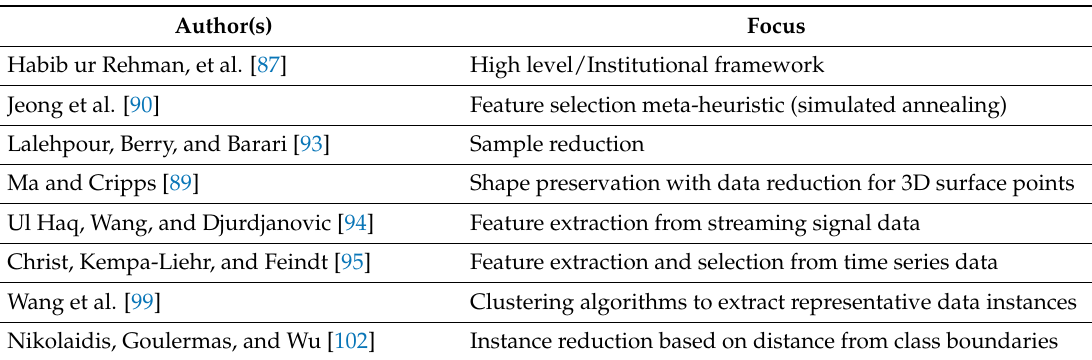
Table 4. Frameworks for data